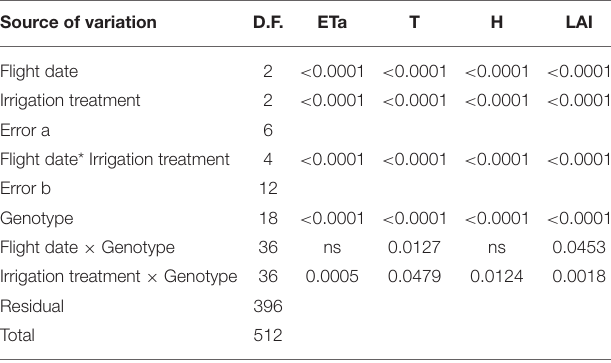
TABLE 2 | P -values of the ANOVAs for the traits estimated through remote